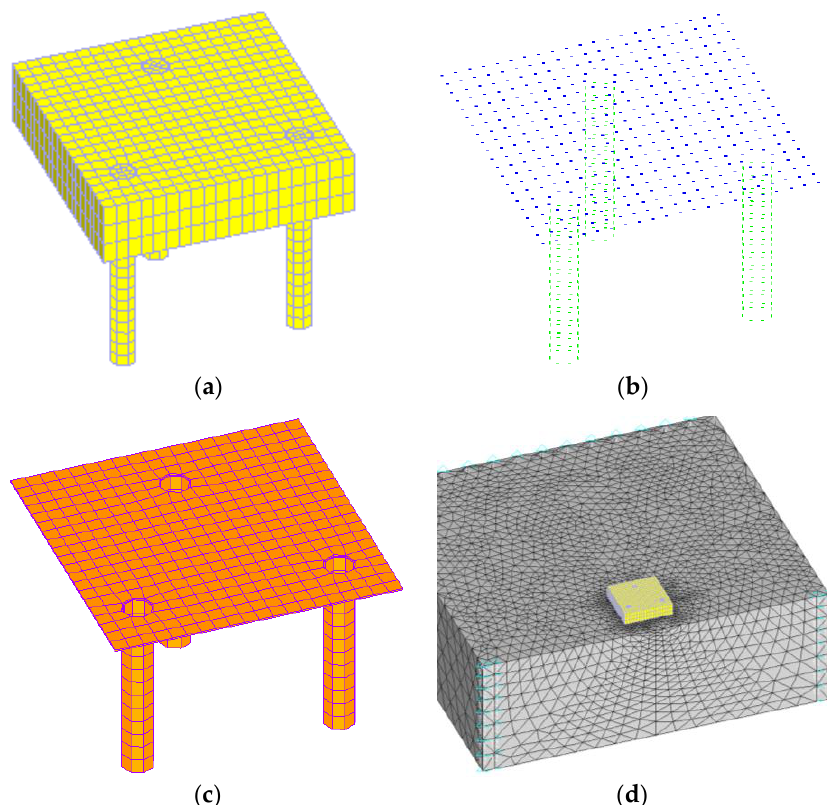
696 Figure 3. Concept of the microplane model: integration point with microplanes ( left ) and decompo- sition of strain vector on the specified microplane ( right )—Figure taken from [16]. The modelling procedure used in this work has been well-proven to realistically sim- ulate the behaviour of anchorages in concrete by various researchers in the past [14,21– 27]. The mesh size, modelling procedure, constitutive law, etc., used in this study corre- sponds well with those used in the past validated investigations. The geometry and material properties of the numerical model corresponded to the parameters used in the experiments reported in [13,14]. The length and width of the con- crete block as well as the boundary conditions were kept such that full concrete edge breakout body could form in all cases. The height of the concrete block was maintained at 500 mm to allow the formation of the unrestricted concrete edge breakout body for the largest edge distance of the back anchor row (240 mm). The base plate and the anchor were considered to be rigidly connected and no hole clearance was modeled. The various components of the numerical model are depicted in Figure 4 for the case of Tri-A (refer to Table 1). The concrete specimen was modeled using solid 4- node tetra- hedral elements while the steel base plate and anchors (steel rods) modeled using solid 8- node hexahedral elements, contact layer between anchor and concrete, contact layer be- tween base plate and concrete, and two types of bar elements. One type of bar elements implemented in MASA can take up both compressive and shear stresses and are used to model bond (mortar) between anchors and concrete. The other type of bar elements can transfer only compressive stresses and are used to model contact between base plate and concrete surface. Contact bar elements, which can take up only compressive stresses, were